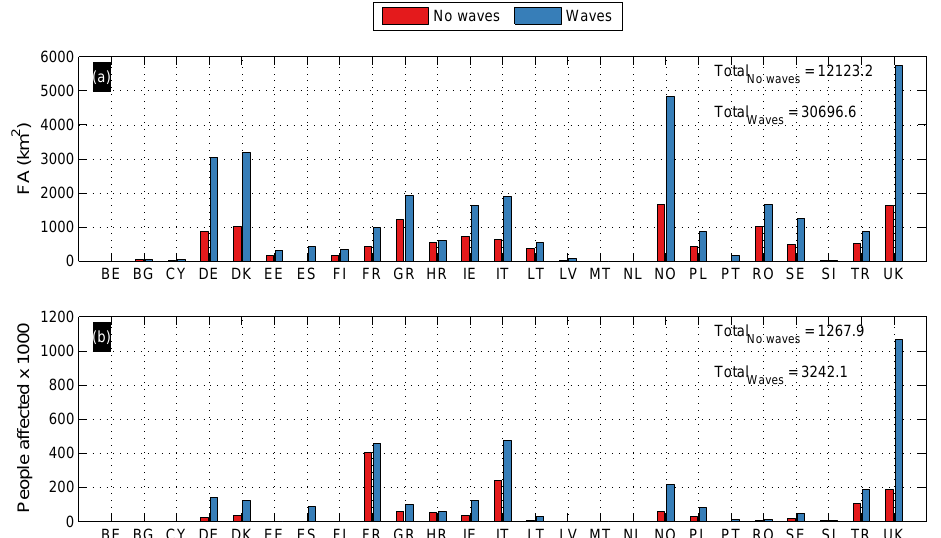
Figure 9. Estimated values of the country level FA (a) and thousands of people affected (b) for the present-day 100-year event; comparisons between the results considering TWLs including/excluding